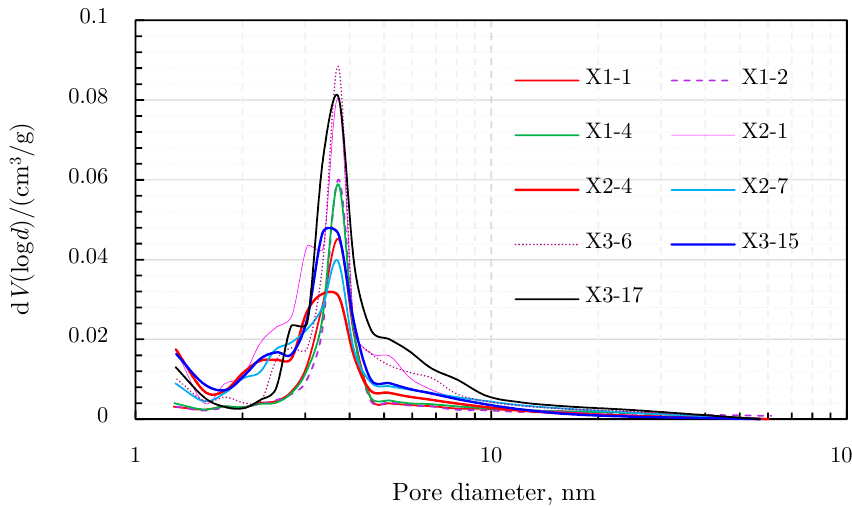
Figure 9. PSD of samples from Longmaxi formation based on low-temperature N 2 adsorption.